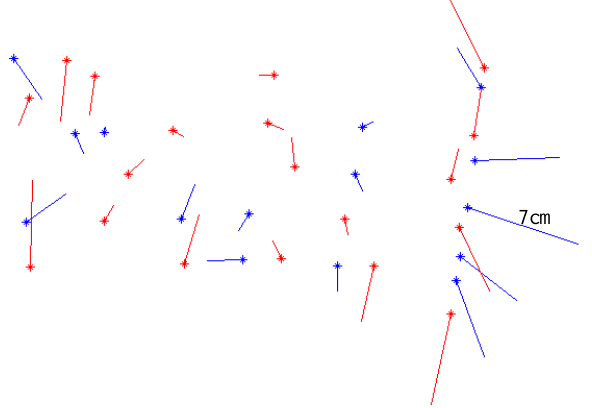
Figure 2: Residuals at GCPs (red) and check points (blue) and their distribution over the building zone for the second epoch (projected onto XY-plane)